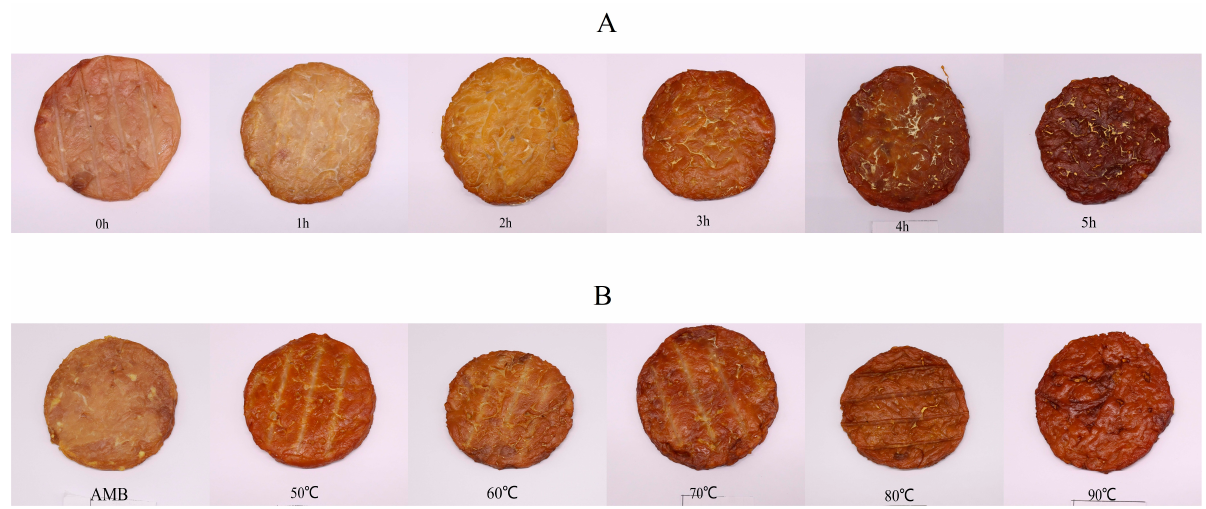
Figure 1. Smoked meat patties at different smoking durations ( A ) and temperatures ( B ). Group 1, in which the meat patties were smoked for 0, 1, 2, 3, 4 and 5 h, at 70 °C; and Group 2, in which the meat patties were smoked for 3 h, at ambient temperatures (AMB), 50, 60, 70, 80 and 90 °C. The surface color of the smoked meat patties was determined according to the method of Zhang et al. [17], but we made a slight change. An automatic colorimeter (Kangguang WB-2000IXA, Beijing, China) was used to measure the color of freeze-dried smoked meat patties. The instrument was calibrated using a standard whiteboard (X = 83.24, Y = 87.98, Z = 91.61). A standard D65 light source, with a 10° field of view, a ф 18 mm reflection measurement aperture and a ф 10 mm projection measurement aperture was also used. After calibration, the meat patty was tiled on the round measuring port for measurement. Then, the lightness ( L* ), redness ( a* ) and yellowness ( b* ) of the sample were recorded. Each sample was analyzed in triplicate. The water activity (Aw, AQUALAB 4TEV, Jinan, China) and cooking loss were de- tected according to the method described by Zhang et al. [17]. The changes in meat pH (METTLER TOLEDO FE20, Shanghai, China) were deter- mined using a previously described assay [18]. The texture properties of the pork patties were measured by TA. XT plus texture an- alyzer (Stable Micro Systems Ltd., Godalming, UK) was used according to the previously described methods, with some modifications [19]. A flat-bottomed cylindrical probe, P/36R (36 mm diameter), was used to perform texture profile analysis (TPA). The test con- ditions used were as follows: 3 mm·s − 1 pre-test speed, 2 mm·s − 1 test speed, 3 mm·s − 1 post- test speed, 50% strain, 5 s dwell time interval and a trigger force of 5 g. 2.5. Determination of the VOCs in Smoked Pork Patties The VOCs in the pork patties were identified by GC-MS (GCMS-QP2020NX, Shi- madzu, Kyoto, Japan), according to the methods described by Rizzo et al. [20], with some modifications. Briefly, 2 g pork patty powder was added to 20 mL glass vials, with Teflon silicon septa lids. An internal standard of 20 µL of 2-methyl-3-heptanone (118.2 µg·L − 1 in methanol) was added to each vial before SPME fiber exposure. The SPME fibers used were 1.0 cm in length with DVB/CAR/PDMS coating (Supelco, Bellefonte, PA, USA). Before ex- posure to the sample bottle, the SPME fiber was pre-heated at 270 °C, for 30 min, in the GC inlet. The sample bottles were equilibrated to 50 °C, for 30 min, during exposure. The samples were then manually injected at a depth of 5.0 cm into a split-less GC inlet, at 250 °C, onto an SH-WAX column (30 m × 0.25 mm, 0.25 µm; Shimadzu), with a constant flow